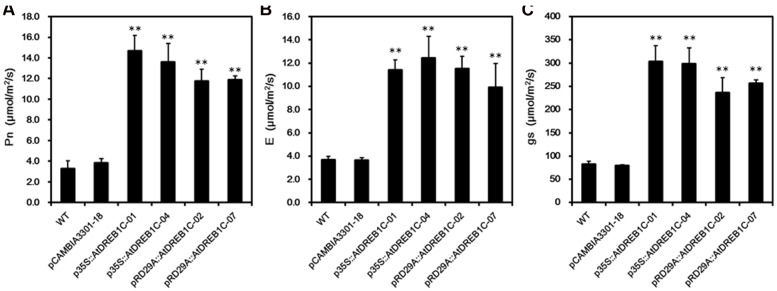
Effects of drought stress on leaf gas exchange parameters in WT and transgenic S. miltiorrhiza plants after withholding watering for 9 days. (A) Net photosynthesis rate (Pn). (B) Transpiration rate (E). (C) Stomatal conductance (gs). WT, wild type. The transgenic lines are indicated by the construct names followed by the line number: p35S::AtDREB1C-01 refers to p35S::AtDREB1C line 01 and so on; pCAMBIA3301-18 was used for the positive control. Bars represent the mean + SE of three independent experiments. ∗∗Significantly different at the P < 0.01 level compared to WT.